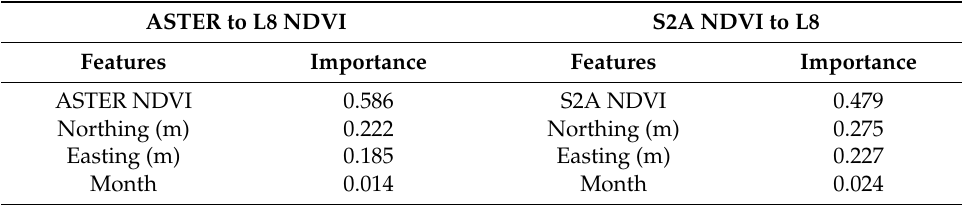
Table 4. Feature importance for the trained random